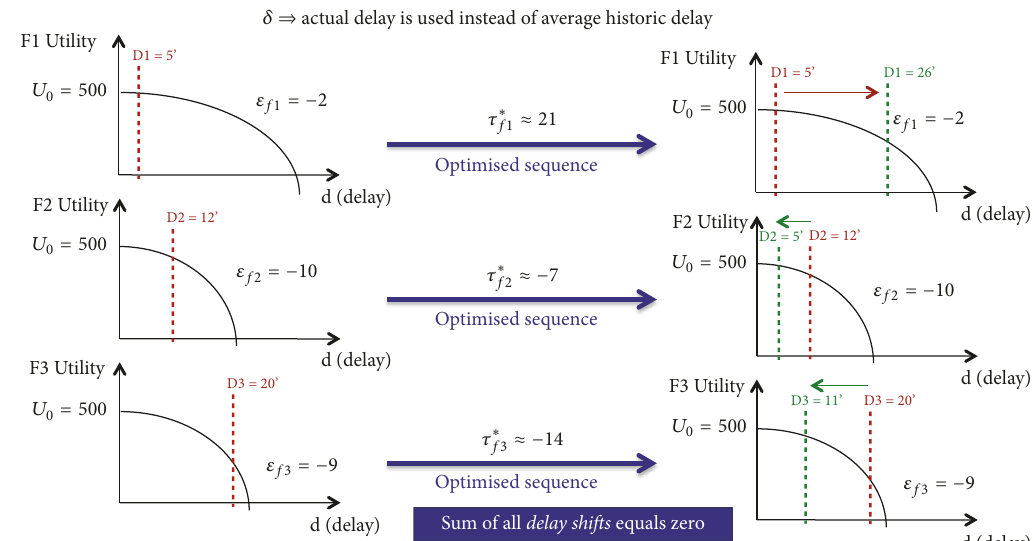
Figure 17: Example of optimal delay redistribution using UDOM.